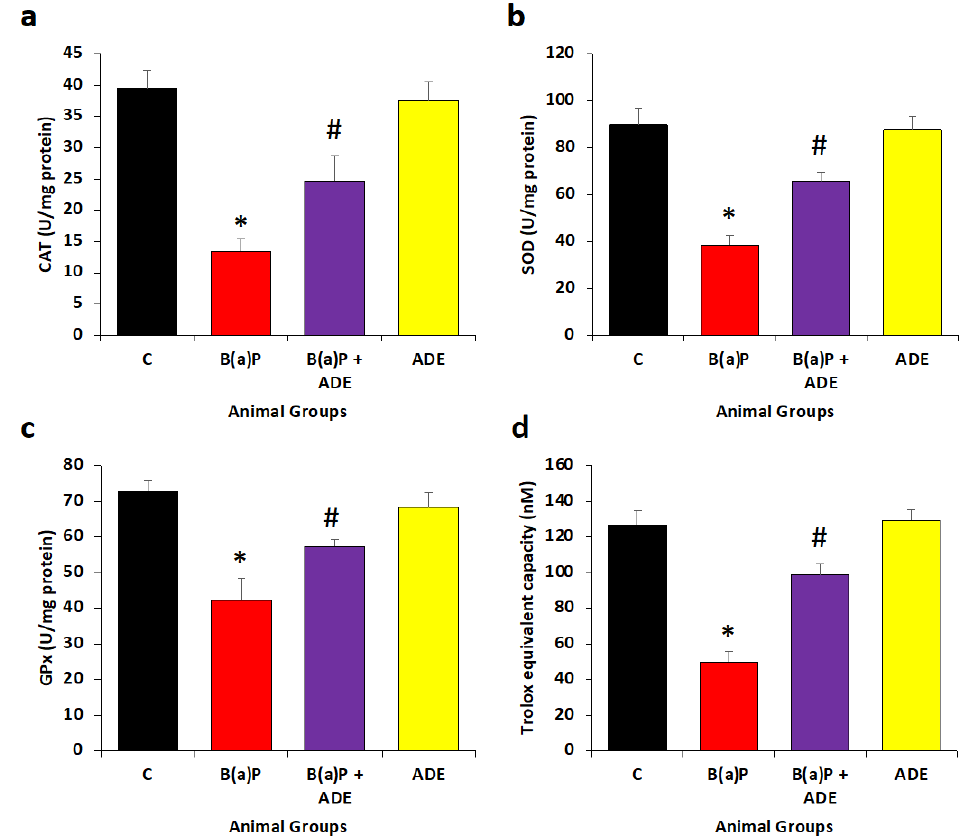
Figure 1. The antioxidant enzymes including ( a ) catalase, ( b ) SOD, ( c ) GPx, and ( d ) total antioxidant capacity were significantly decreased in B(a)P-treated group. The levels of enzymes were significantly enhanced in the ADE treatment group. The number signifies the mean ± SEM with 8 animals per group. The statistical differences are represented with (*) asterisk representing significance at ( p < 0.05) as compared to the control group and (#) hash represents ( p < 0.05) when compared with B(a)P-treated group.